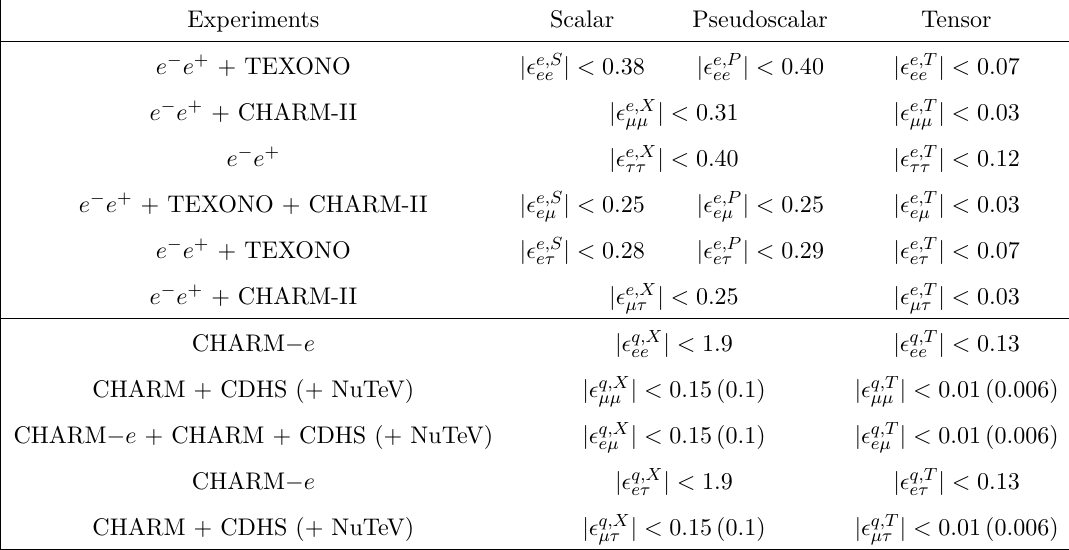
Table 6 . Combined 90% C.L. limits on the different scalar, pseudoscalar, and tensor neutrino interaction parameters, with X = S, P . For each suitable parameter, we also show in brackets the corresponding limits including the NuTeV measurements.